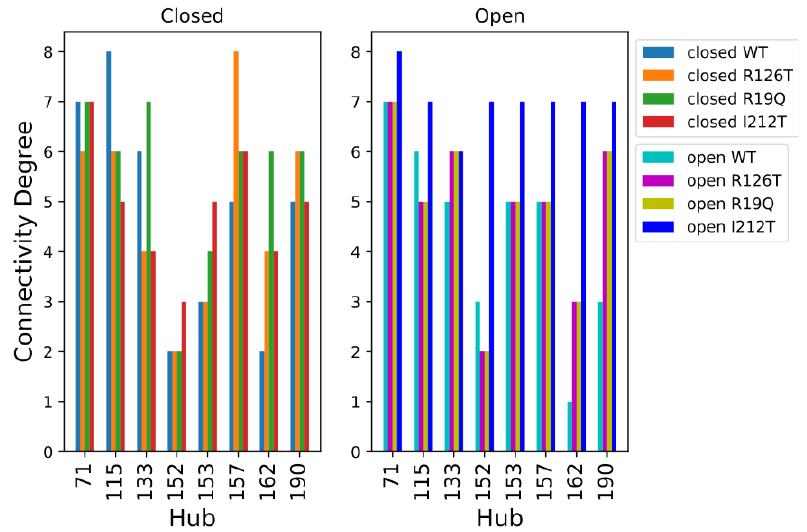
Figure 9. Hub degree comparison of all systems. Residues are enumerated in PDB notation; thus, the correct position can be obtained by adding 2 to the PDB index (e.g., residue R126 is found at index 128).